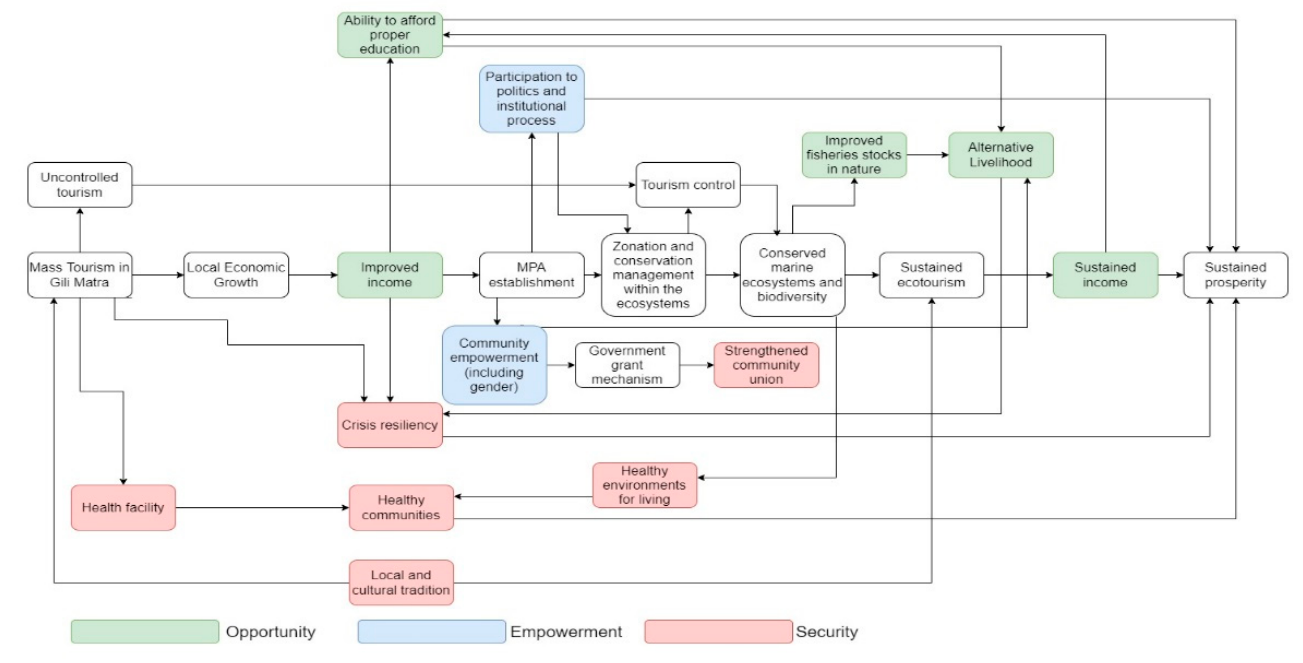
Figure 4. Mental model of influential stakeholders in the Gili Matra MPA and the MPA’s influence on local prosperity. Each box represents a situation in Gili Matra that is related to the prosperity and MPA management in Gili Matra. The colored boxes indicate their categorization to the World Bank domains of prosperity (opportunity, empowerment, security), while the transparent boxes indicate no inclusion regarding the mentioned domains. The mentioned stakeholders emphasize the importance of the MPA in providing sustained future prosperity.